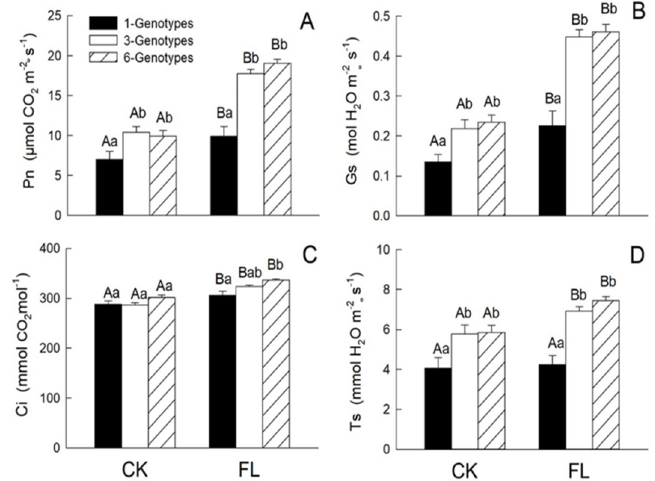
Figure 3. Effects of genotypic diversity and flooding on photosynthetic physiology traits ( A ) Pn, ( B ) Gs, ( C ) Ci and ( D ) Ts of H. vulgaris (mean ± SE). The control and flooding treatments were named as CK and FL, respectively. Different capital letters indicate significant differences among genotypic diversity treatments, and lower-case letters indicate significant differences among flooding treatments ( p < 0.05).